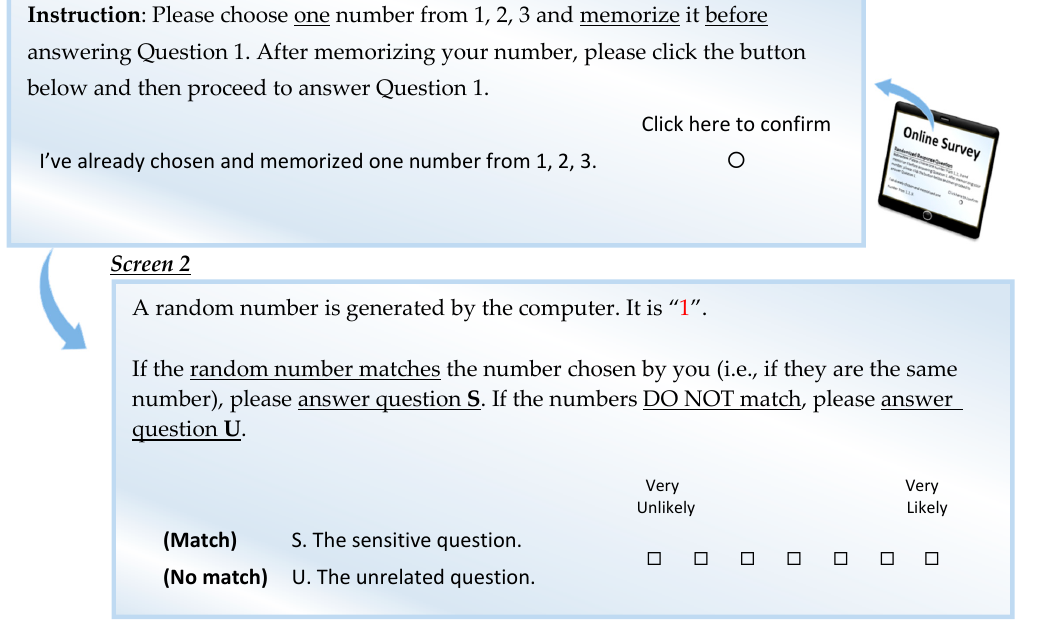
Figure 2. An example of this study’s randomization procedure.